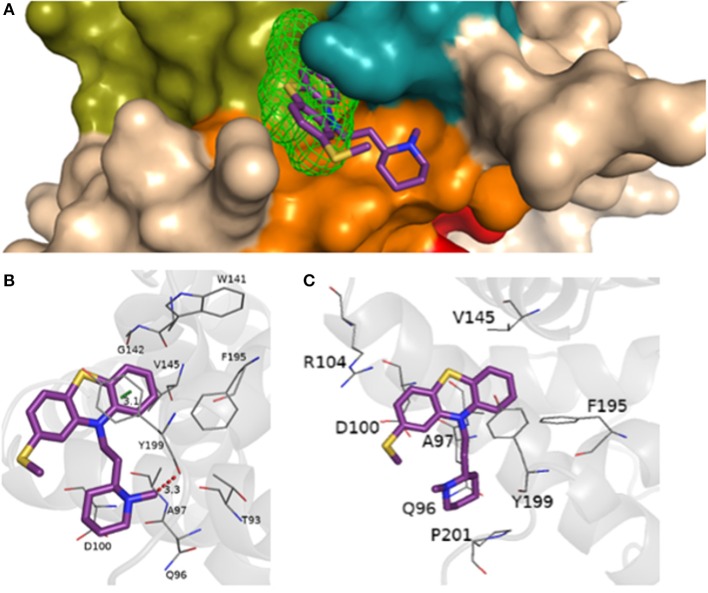
(A) Representation of the BH1-BH4 domains with the presence of the site 2 detected from FTSite and the molecular docking of thioridazine, piperidine subclass, EC50 = (45.5 ± 1.0) μmol.L−1, performed at AutoDock Vina 1.5.7. Representation of hydrogen bonding (red) from the molecular docking performed in AutoDock Vina 1.5.7, (B) in the Achilles Blind Docking Server, (C) and the additional interactions and/or confirmed by BINANA 1.2.0.